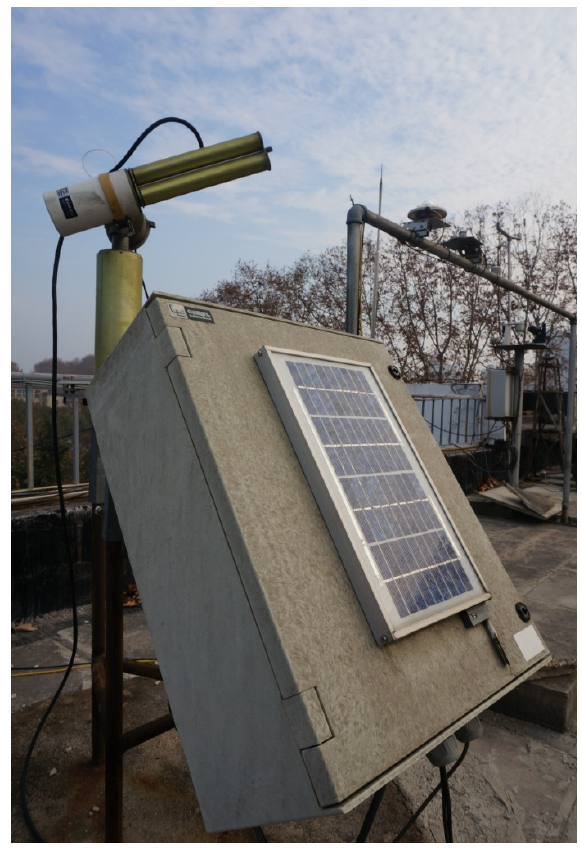
Figure 2. The sun photometer at Wuhan